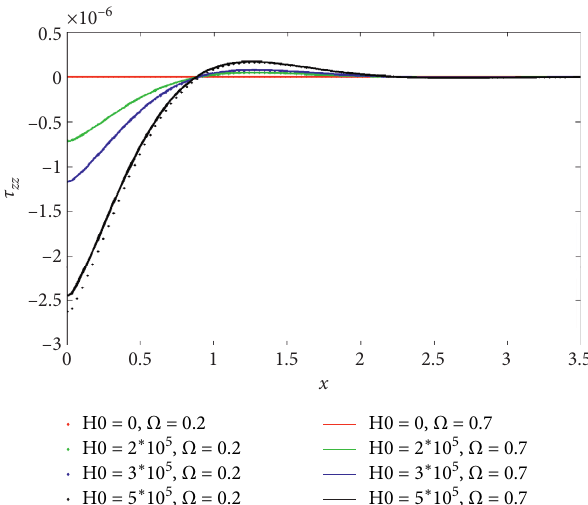
Figure 30: Stress σ